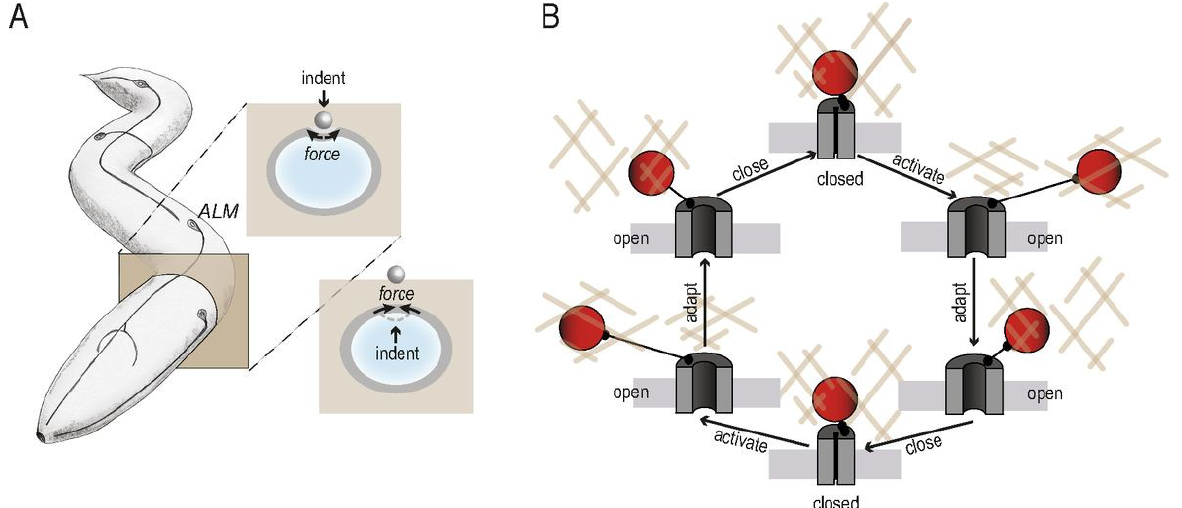
Figure 8. Gating mechanism of MeT channels in C. elegans touch receptor neurons (TRNs). ( A ) Schematic representation of the forces acting on TRNs in consequence of cuticle indentation. ( B ) Schematic representation of a possible gating model of MeT channels. An elastic filament links the channel to an anchor that moves in the extracellular matrix [213]. In clockwise order from top to bottom: a deformation applied to the extracellular matrix causes a lateral shift between the anchor and the matrix and induces a stretch of the filament that activates the channel. Viscoelastic forces allow the filament to return into its relaxed state, inducing the channel adaption and closure. When the external deformation is released, a second lateral shift of the anchor with respect to the extracellular matrix occurs, resulting in the channel opening. Finally, the initial configuration is restored by viscoelastic forces. Figure adapted from [213] under the exclusive License to